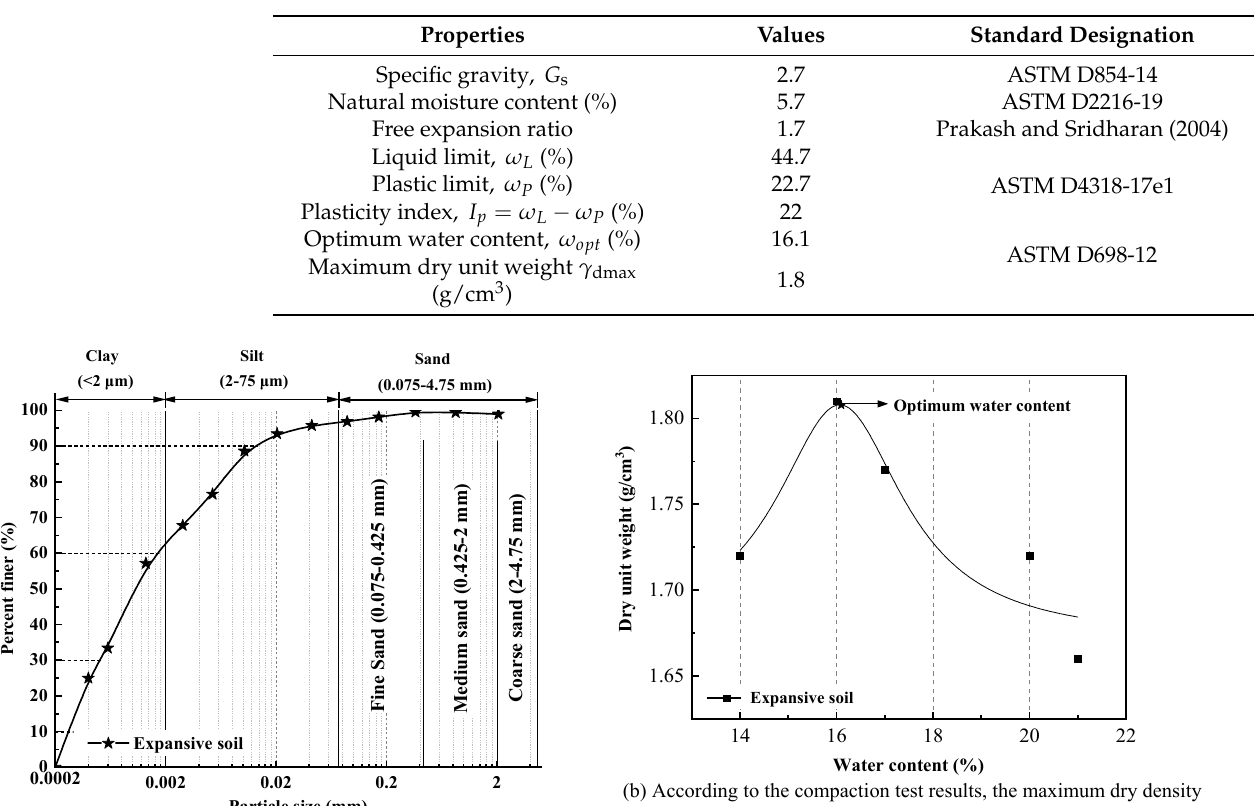
Table 1. Physical properties of the selected expansive soil.